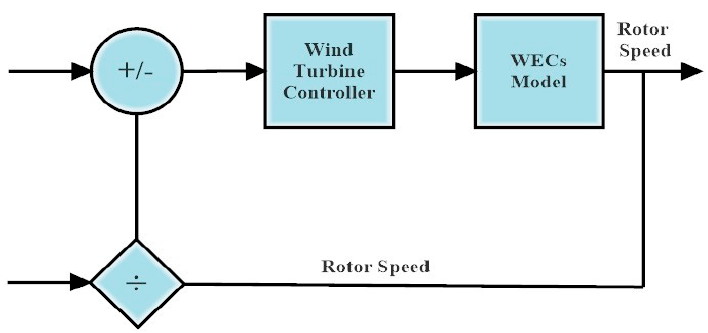
Figure 11. Basic block illustration of TSR.